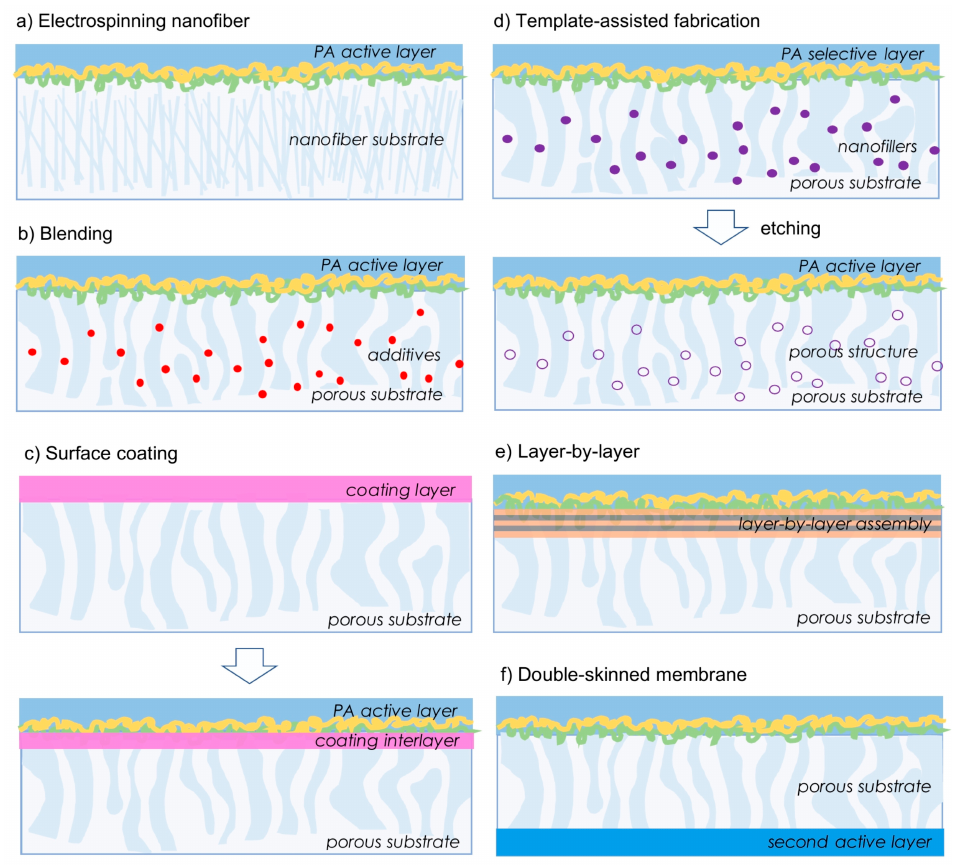
Figure 3. Schematic illustration representing strategies for substrate fabrication and modification; ( a ) electrospinning nanofiber; ( b ) blending technique; ( c ) surface coating; ( d ) template-assisted fabrication; ( e ) layer-by-layer assembly; ( f ) double-skinned